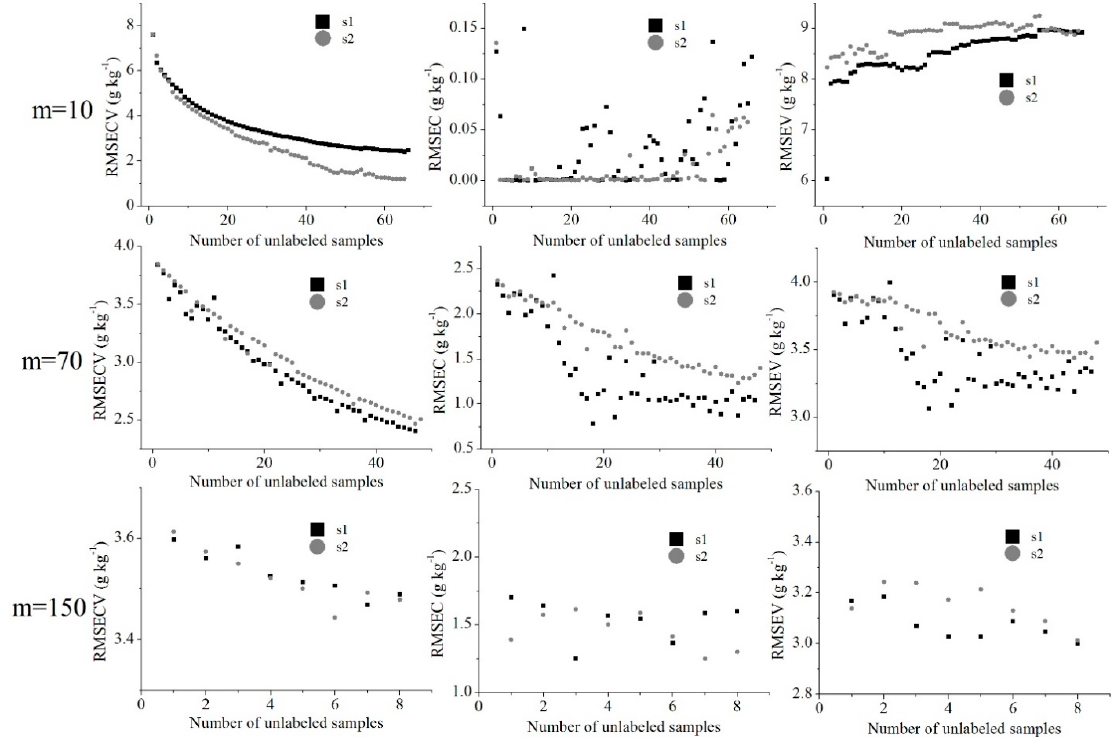
Figure 4. Behaviors of root mean square error of cross-validation (RMSECV), root mean square error of calibration (RMSEC) and root mean square error of validation (RMSEV) achieved by regressors s1 and s2 versus the number of unlabeled samples exploited when 10, 70 and 150 labeled samples (m) were used in Co-LSSVMR, respectively.